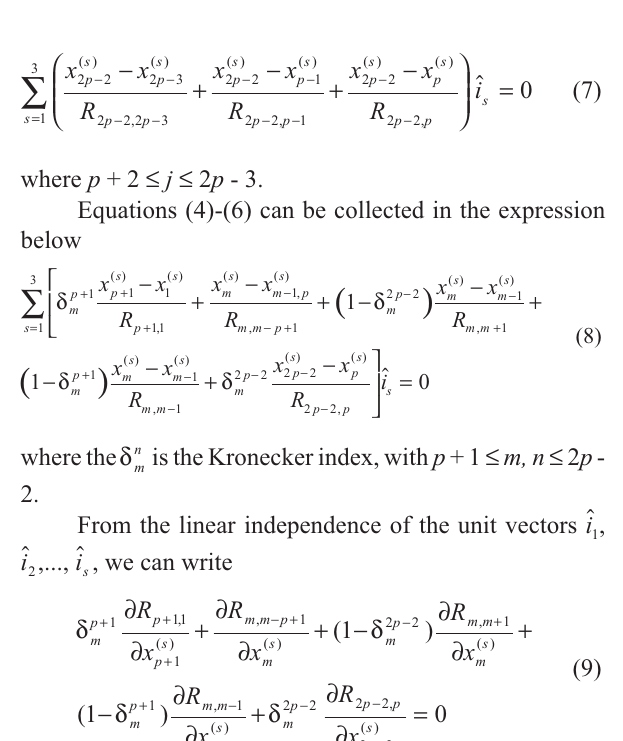
Figure 1 - The fishbone structure for a Steiner tree with p leaves and p - 2 nodes (Steiner